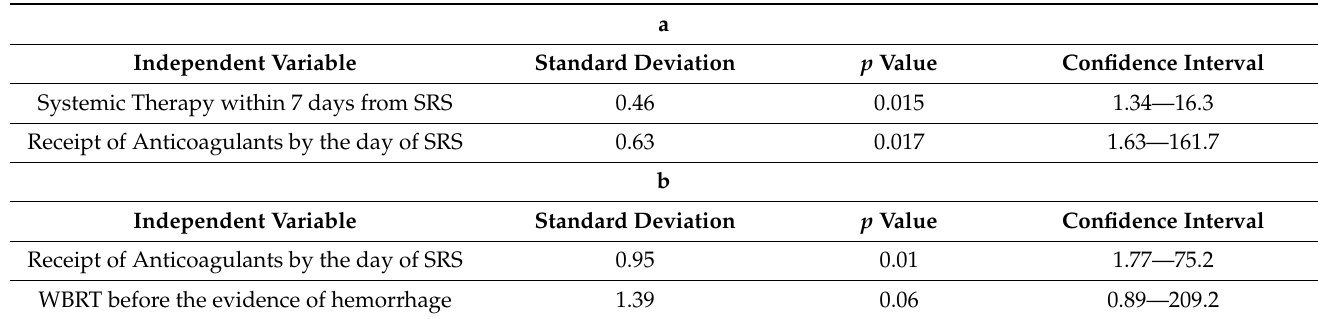
Table 5. Logistic Regression model with dependent variable. ( a ) radiological evident hemorrhage. ( b ) hemorrhage causing toxicity ≥ grade